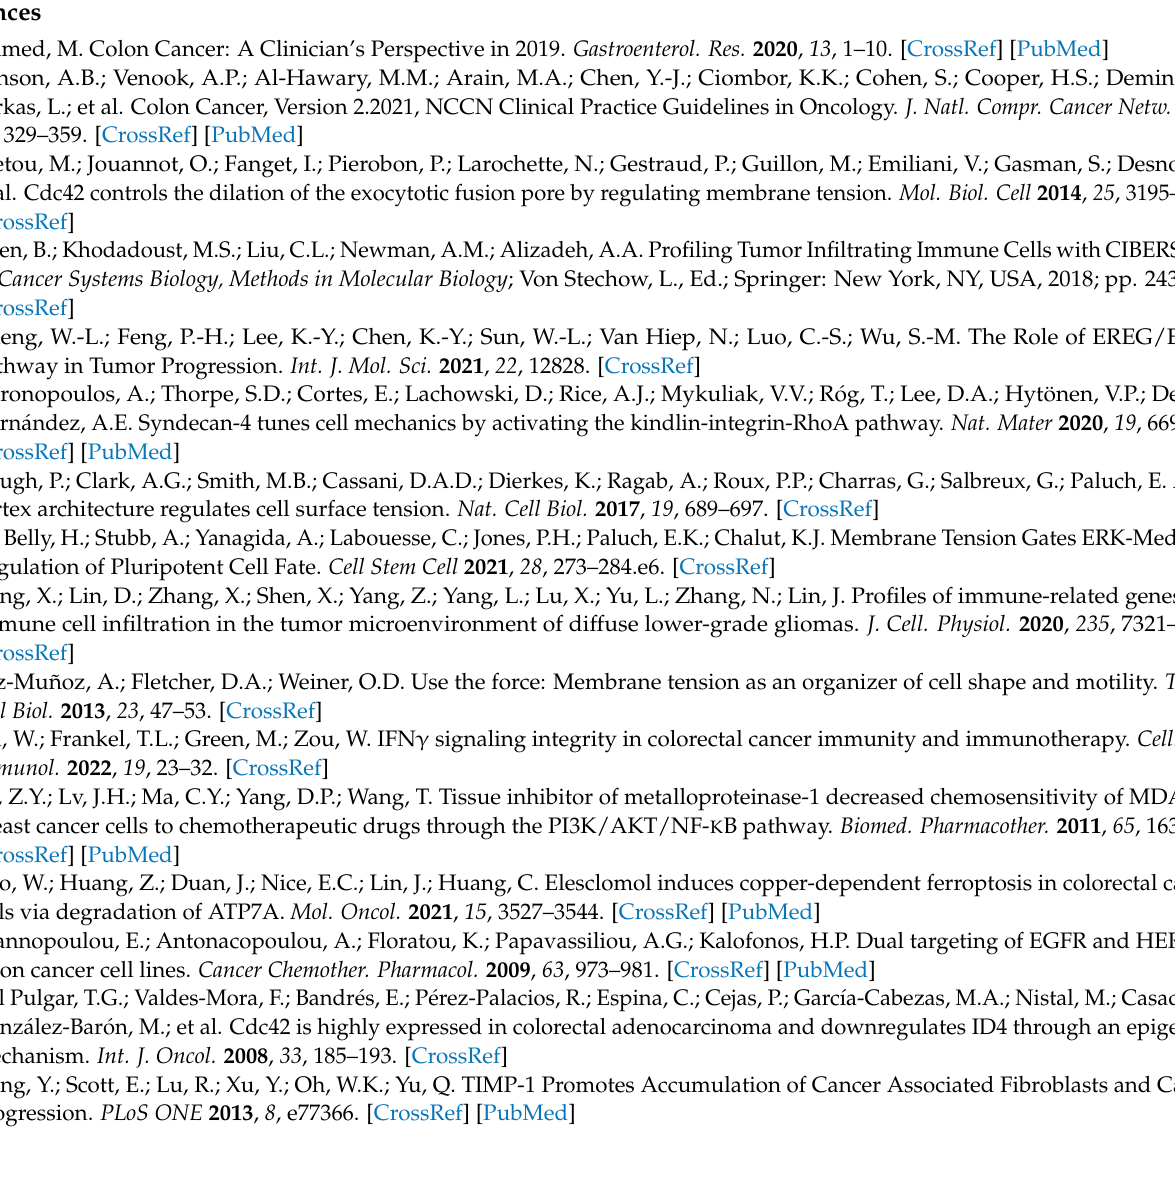
COAD patients in the present study. Table S2. 44 membrane tension-related genes. Table S3. Multivariate COX regression analysis results of model genes. Table S4. Molecular docking scores of the three compounds. Figure S1. The boxplots for the comparison of the immune checkpoints genes between the high-risk and low-risk groups in the colon cancer patients. Figure S2. InferCNV analysis in epithelial cell subsets. Figure S3. Drug sensitivity analysis in the high-risk and low risk groups in colon cancer